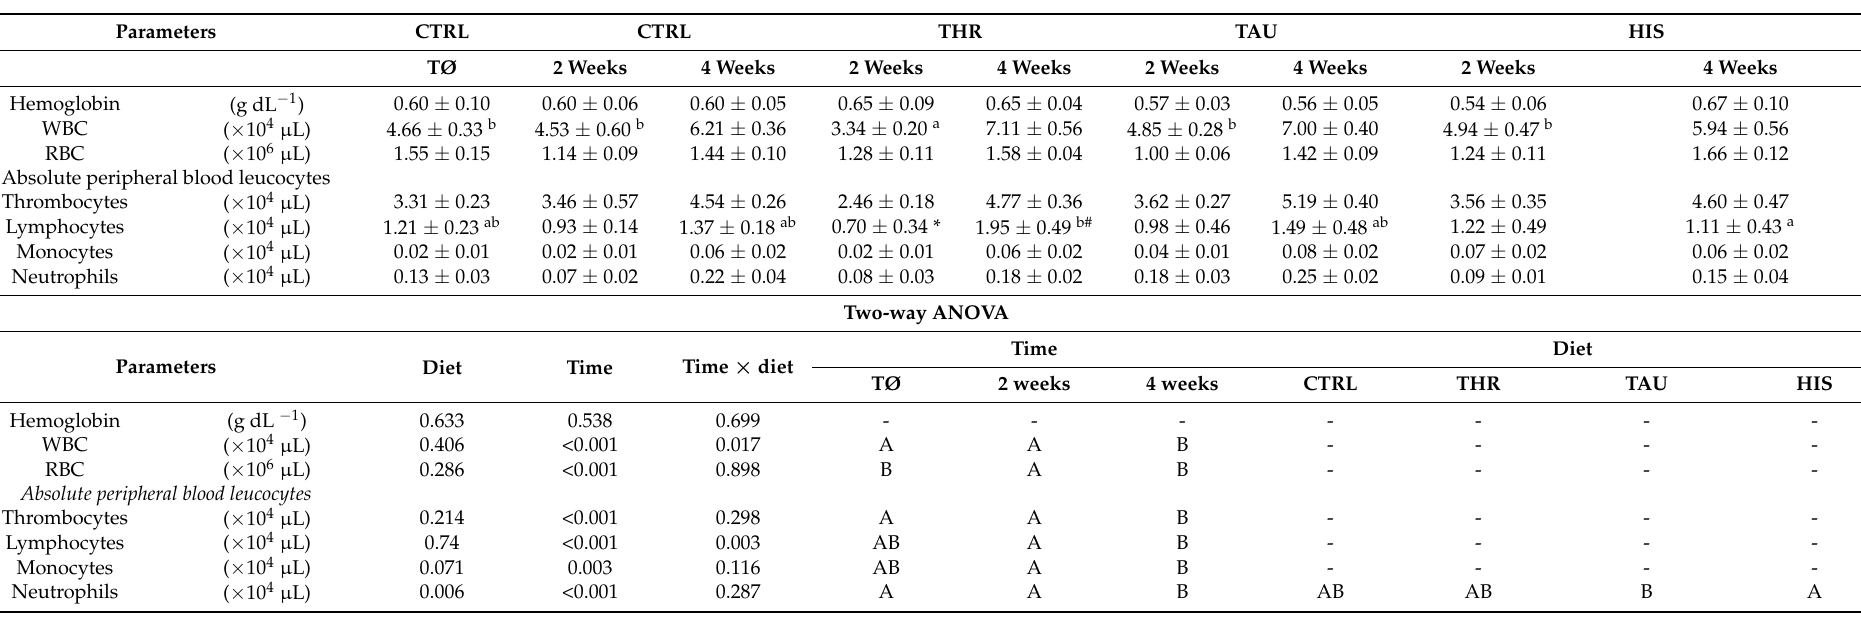
Table 5. Hemoglobin, red blood cells (RBC), and white blood cells (WBC) of gilthead seabream fed dietary treatments during two and four weeks.